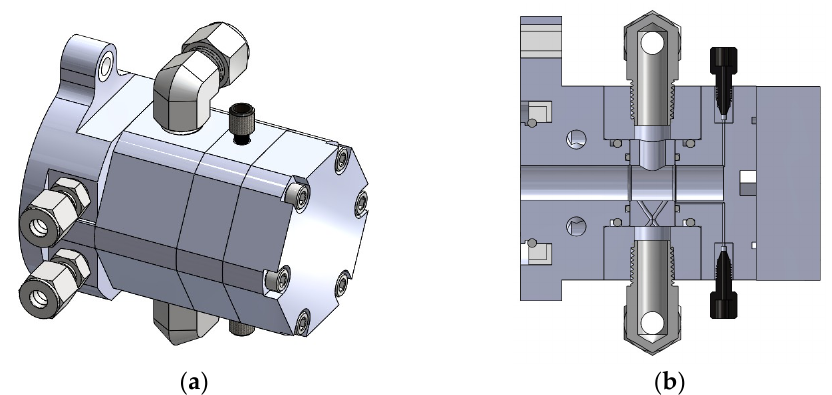
Figure 6. BN-124 target: ( a ) Isometric and ( b ) vertical mid-plane cross-section views.